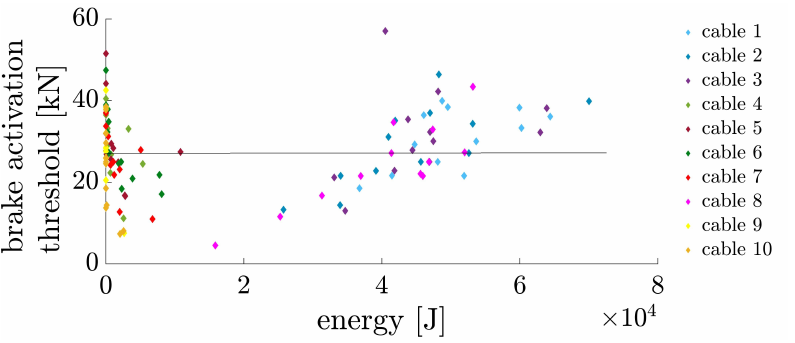
Figure 23. Local dissipated energy variations according to brake-activation threshold in each